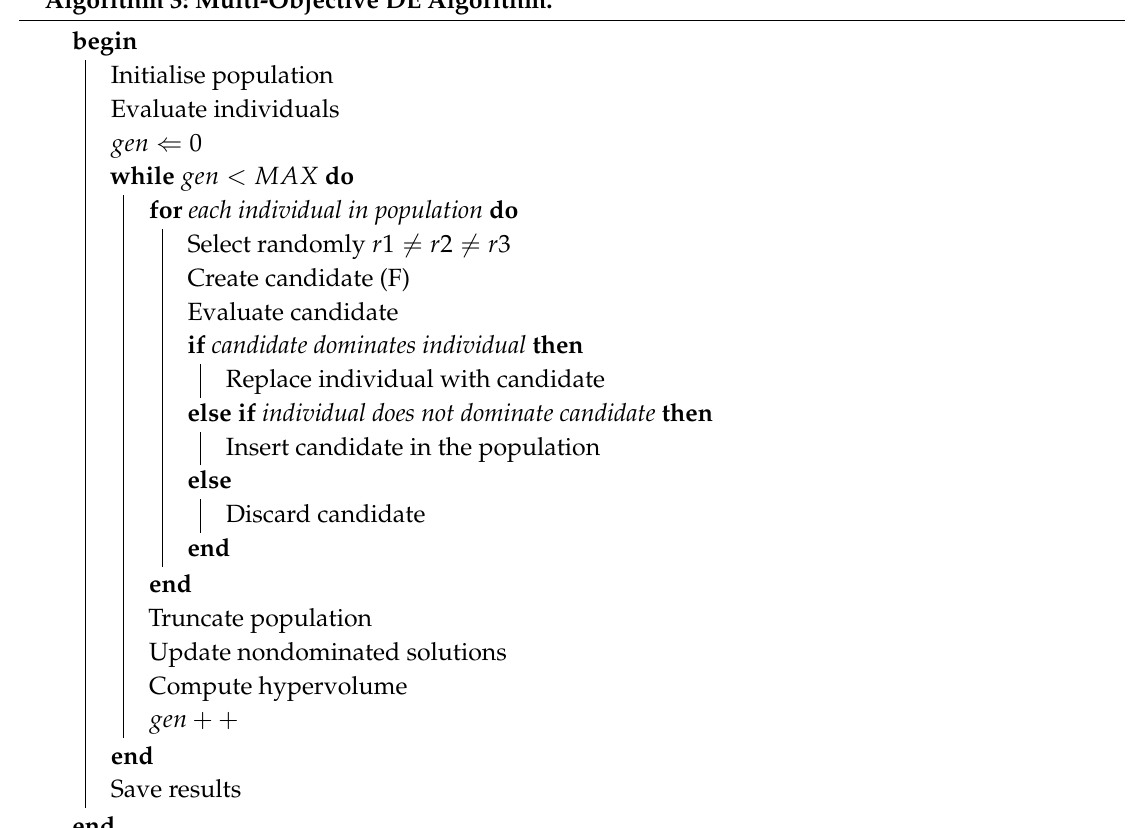
Algorithm 3: Multi-Objective DE